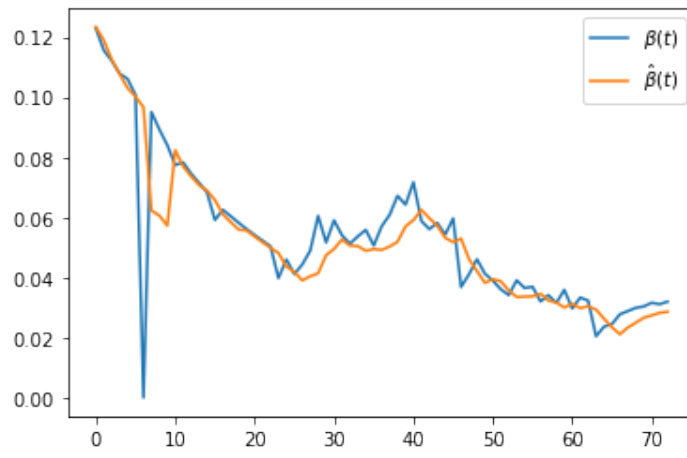
Figure 4. β rates during the given period.